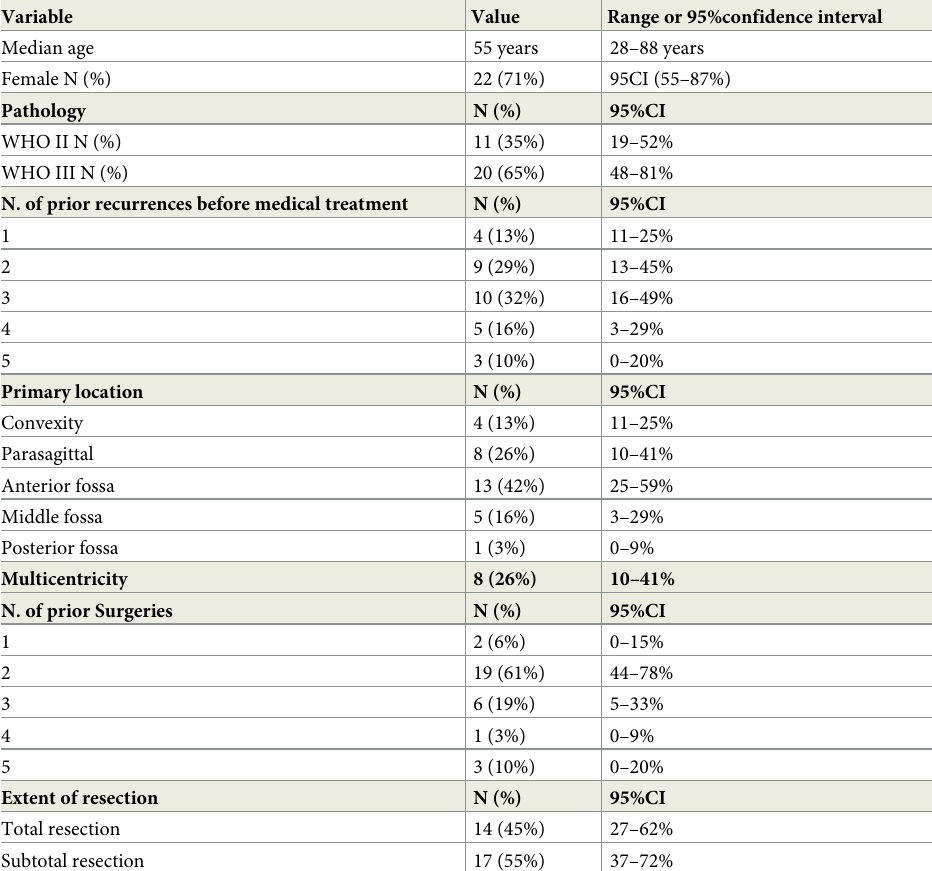
Table 1. Patient